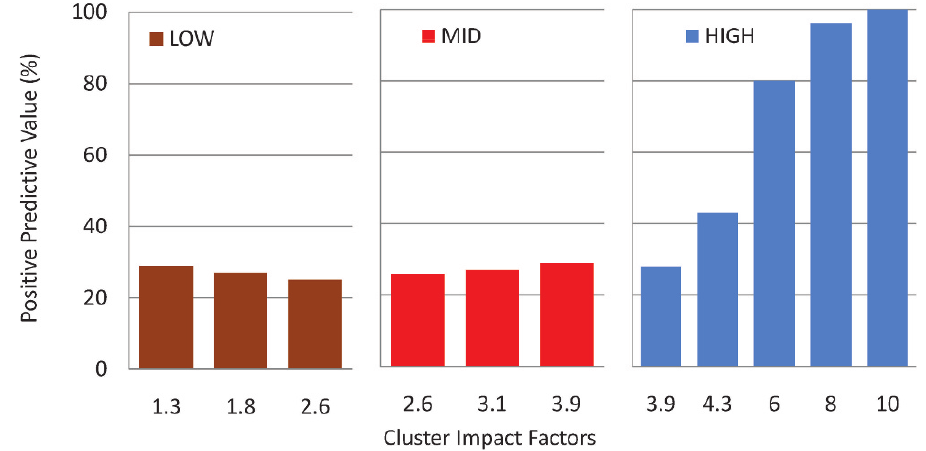
Figure 5 - Average Positive Predictive Value (PPV) for 8,273 articles published in 60 journals divided into nine Impact Factor clusters (classes LOW, MID, HIGH). Boundary clusters are repeated in each class. An article is deemed a ‘‘True Positive’’ if its cites/year is within its class, as a ‘‘False Positive’’ if otherwise. PPVs are extremely low (23-27%) in all clusters of the ‘‘LOW’’ and ‘‘MID’’ groups, but rise progressively with IF in the